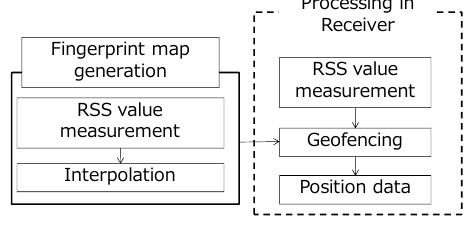
Figure 4. Fingerprint-based